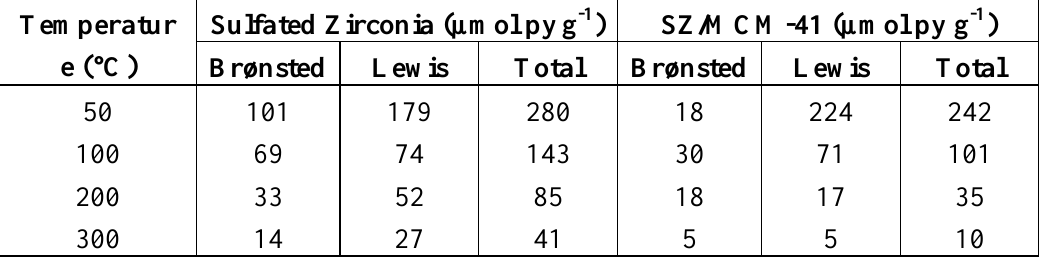
Table 1. Acidity measurement results for SZ and SZ/MCM-41.